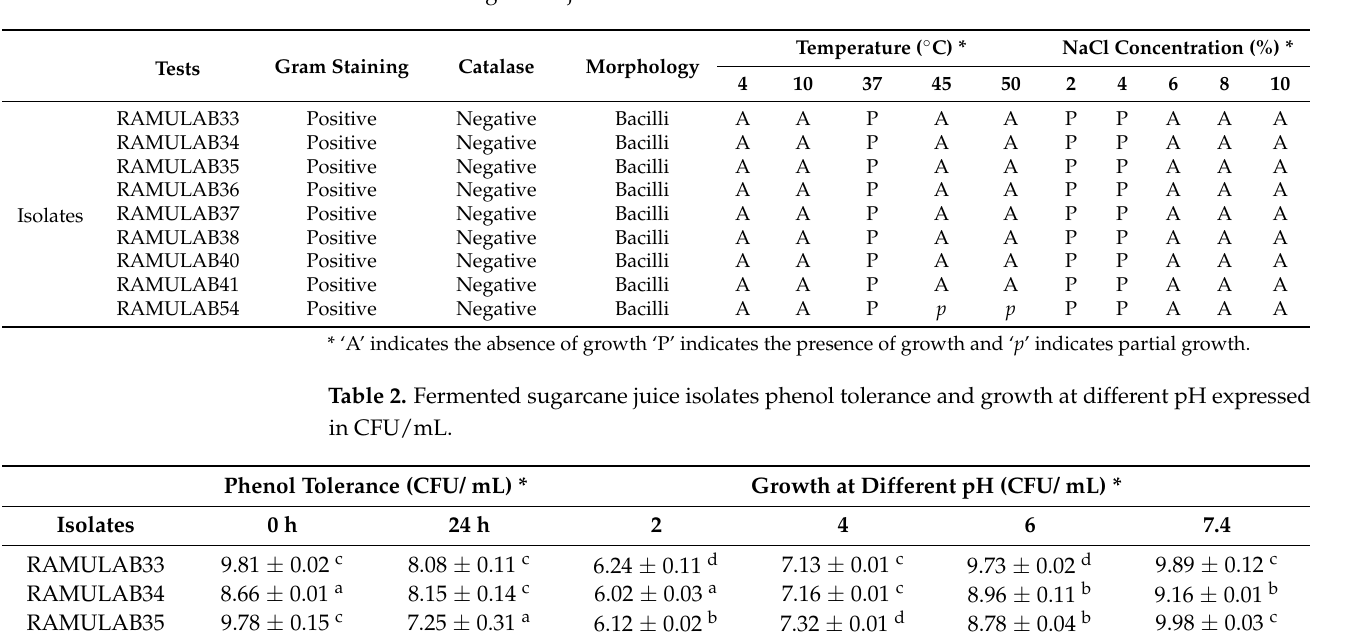
Table 1. The phenotypic characteristics and tolerability of the LAB strains isolated from the sample of fermented sugarcane juice.